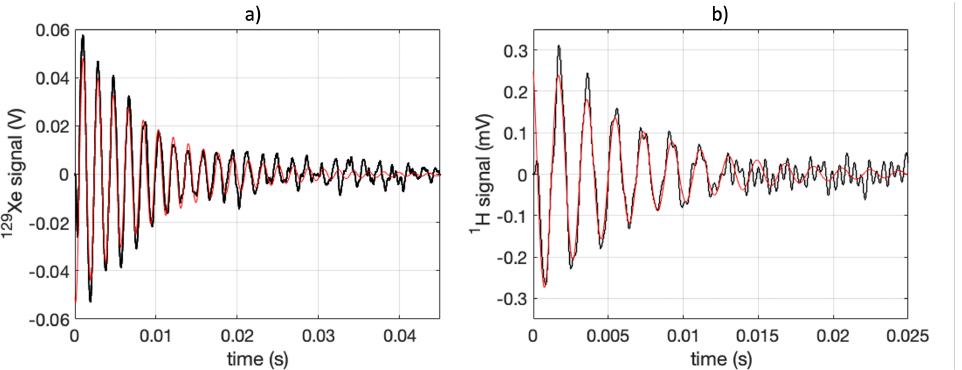
Figure A6. FIDs acquired on the polarizer. The black line is the signal and the red line is the fitted FID. ( a ) 1 scan 129 Xe FID, with V = 53.6 mV and T ∗ scan average 1 H FID, with V = 0.307 mV and T ∗